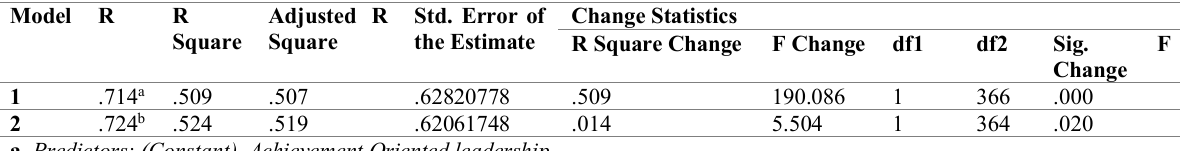
Table 8: Regression Model Summary for Achievement-Oriented Leadership Style